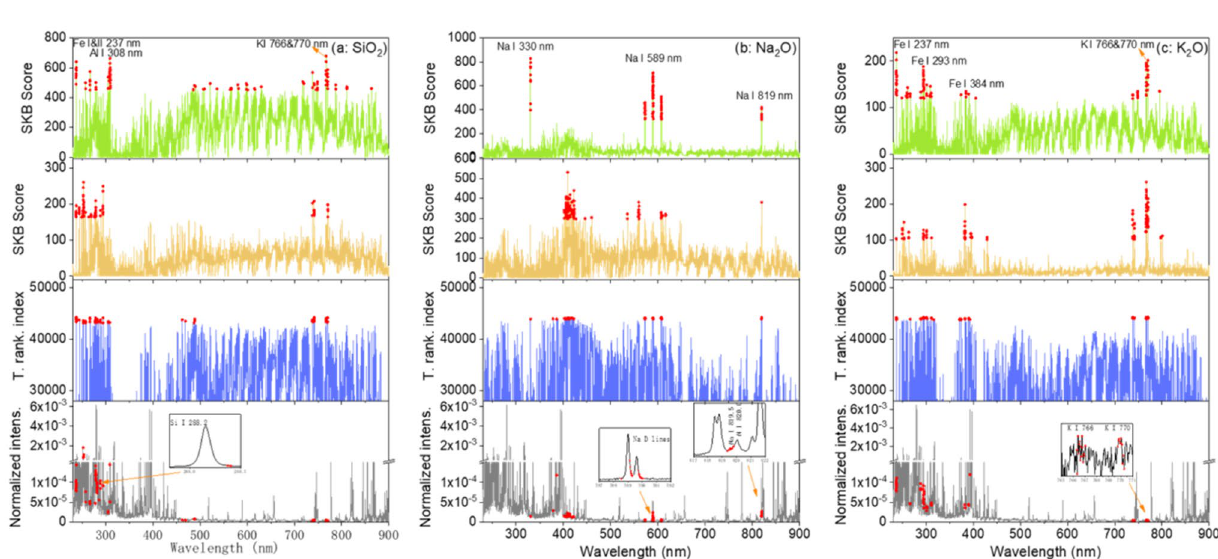
Figure 11. Results of feature selection for the pair of sample types pellets/polished rocks: for ( a ) SiO 2 , ( b ) Na 2 O and ( c )